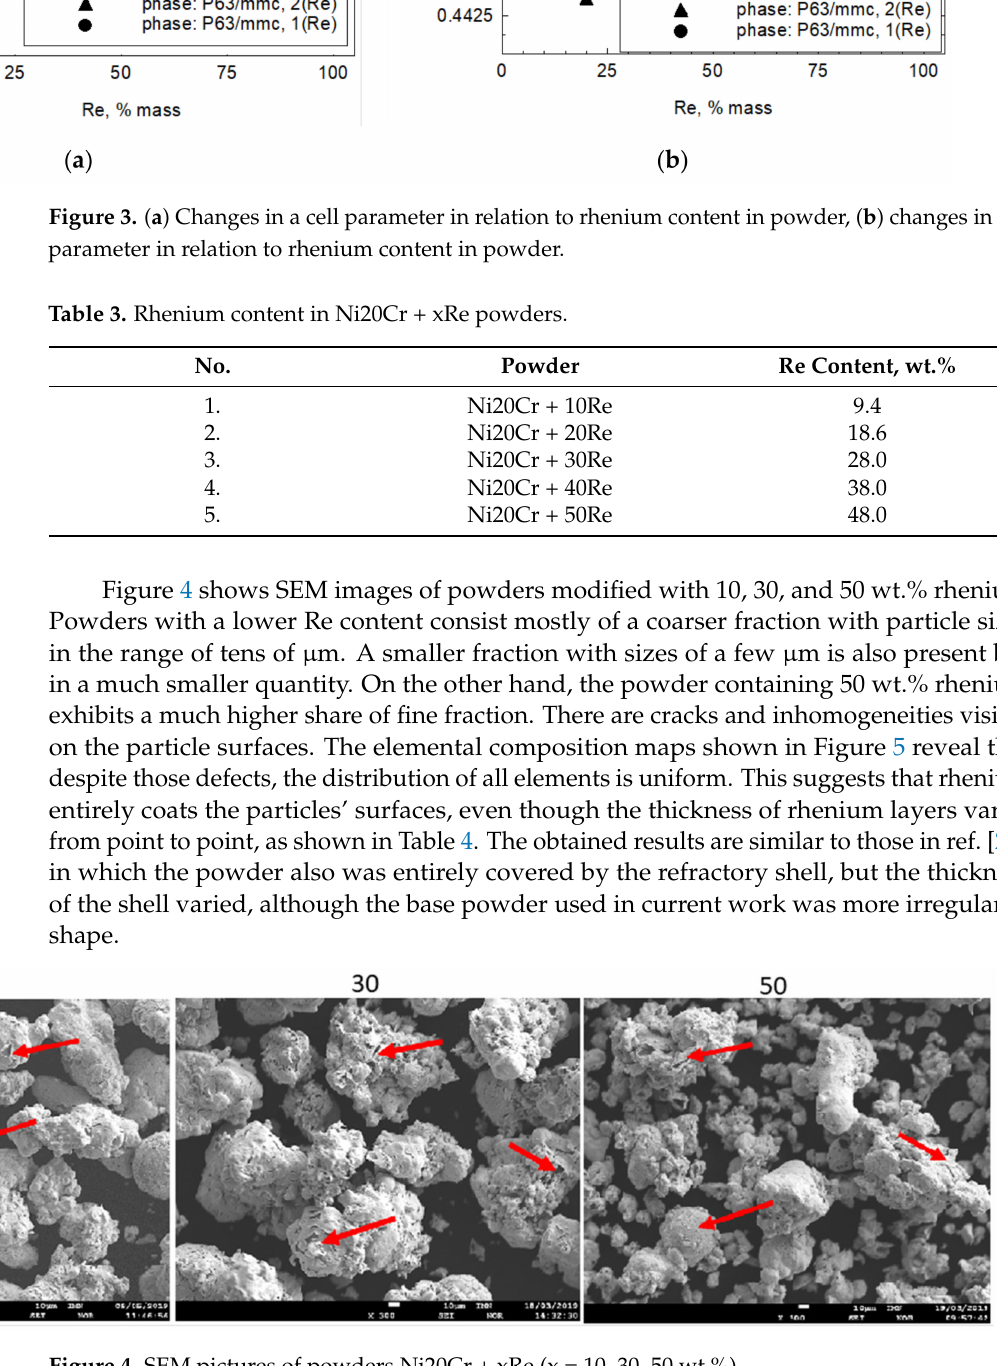
Figure 4. SEM pictures of powders Ni20Cr + xRe (x = 10, 30, 50